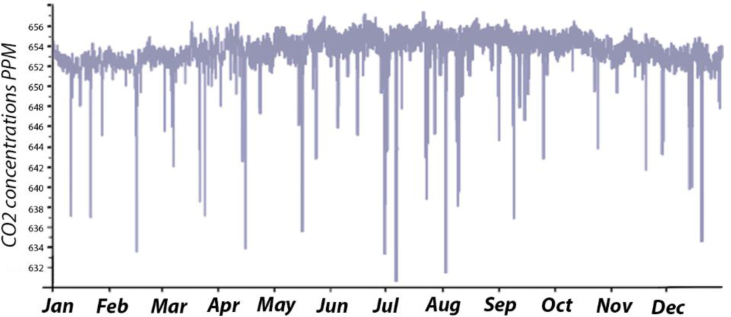
Annual CO2 concentration inside the classroom in the B.C (ppm).